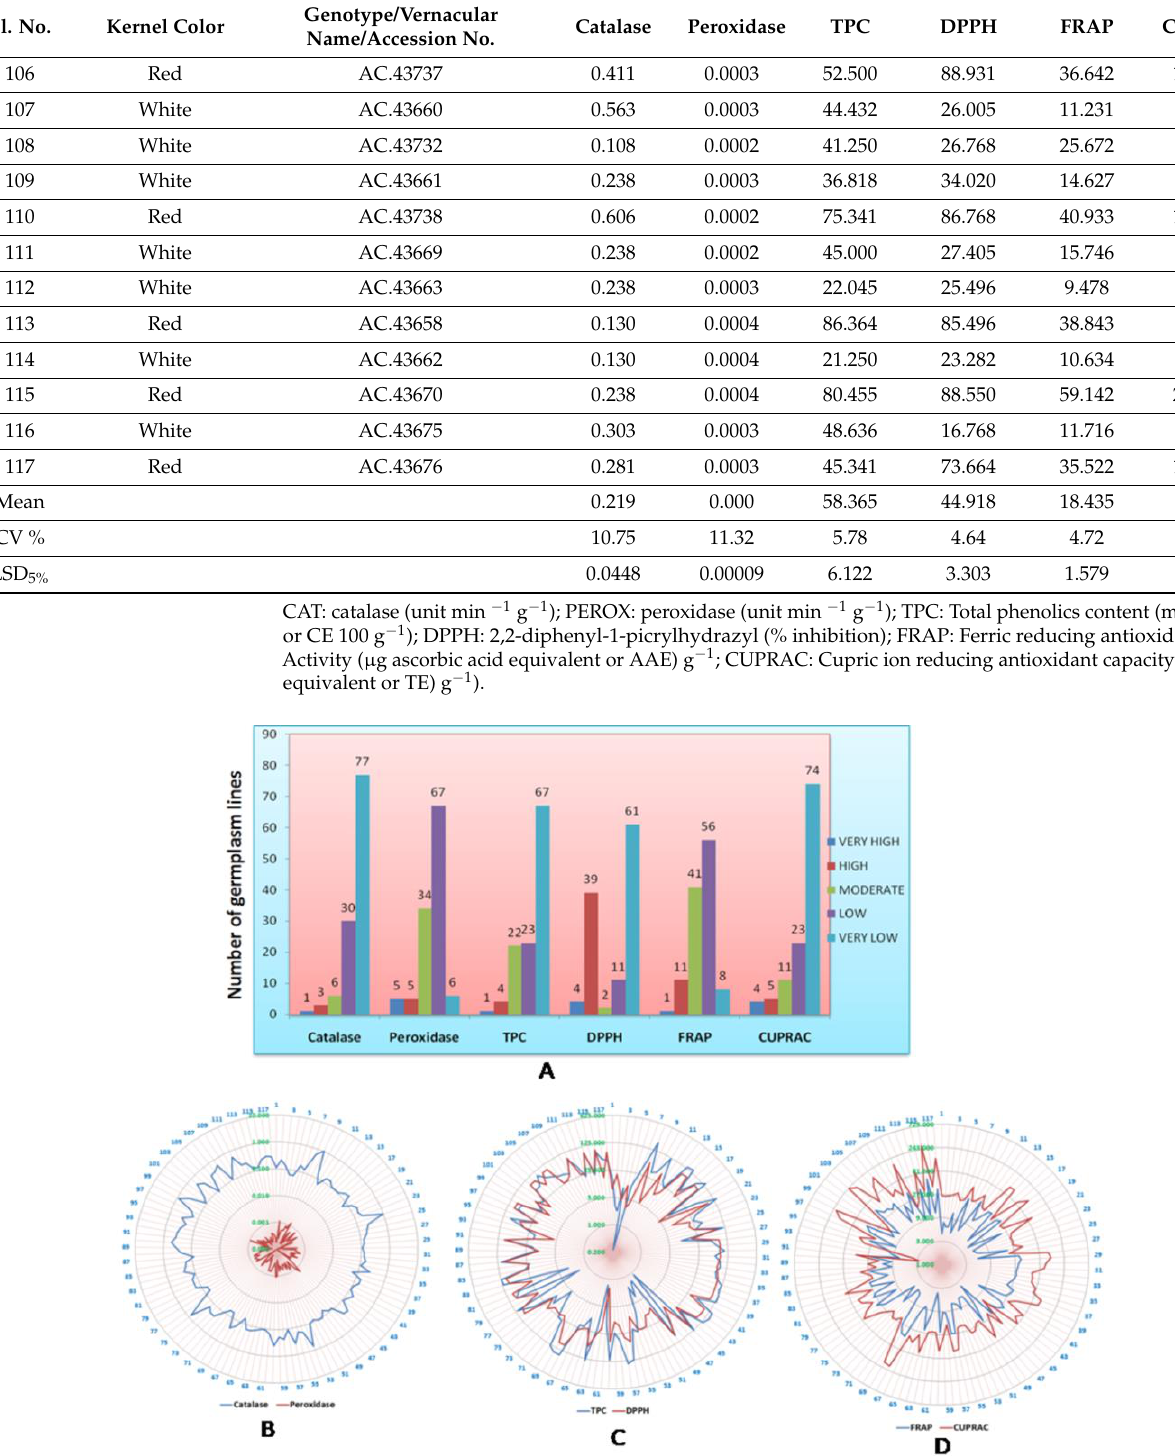
Figure 2. ( A ). Frequency distribution of germplasm lines for antioxidant properties, catalase, peroxidase, total phenolics content (TPC), 2,2-diphenyl-1-picrylhydrazyl (DPPH), ferric reducing antioxidant power (FRAP) and cupric ion reducing antioxidant capacity (CUPRAC) present in the panel population of 117 genotypes. ( B ). Spider graph showing the catalase and peroxidase activities. ( C ). TPC content and DPPH activities. ( D ). FRAP and CUPRAC activities.